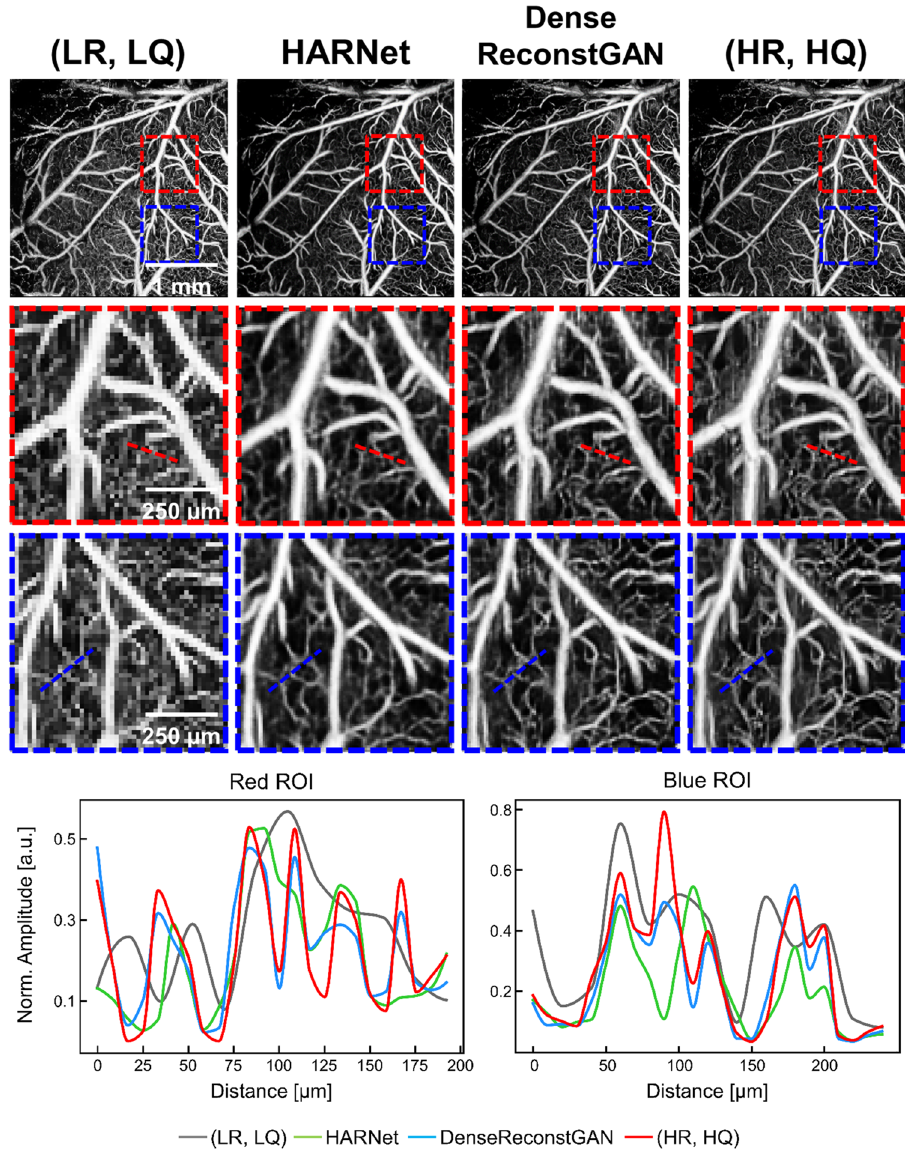
Figure 5. Qualitative performance of our DenseReconstGAN and HARNet for reconstructing at a downsampling ratio of two. Enlarged profiles of the boxed regions of interest (ROI) are illustrated. Vessel profiles along the dashed lines within each ROI are also illustrated. (LR, LQ) low-resolution and low-quality, (HR, HQ) high-resolution and high